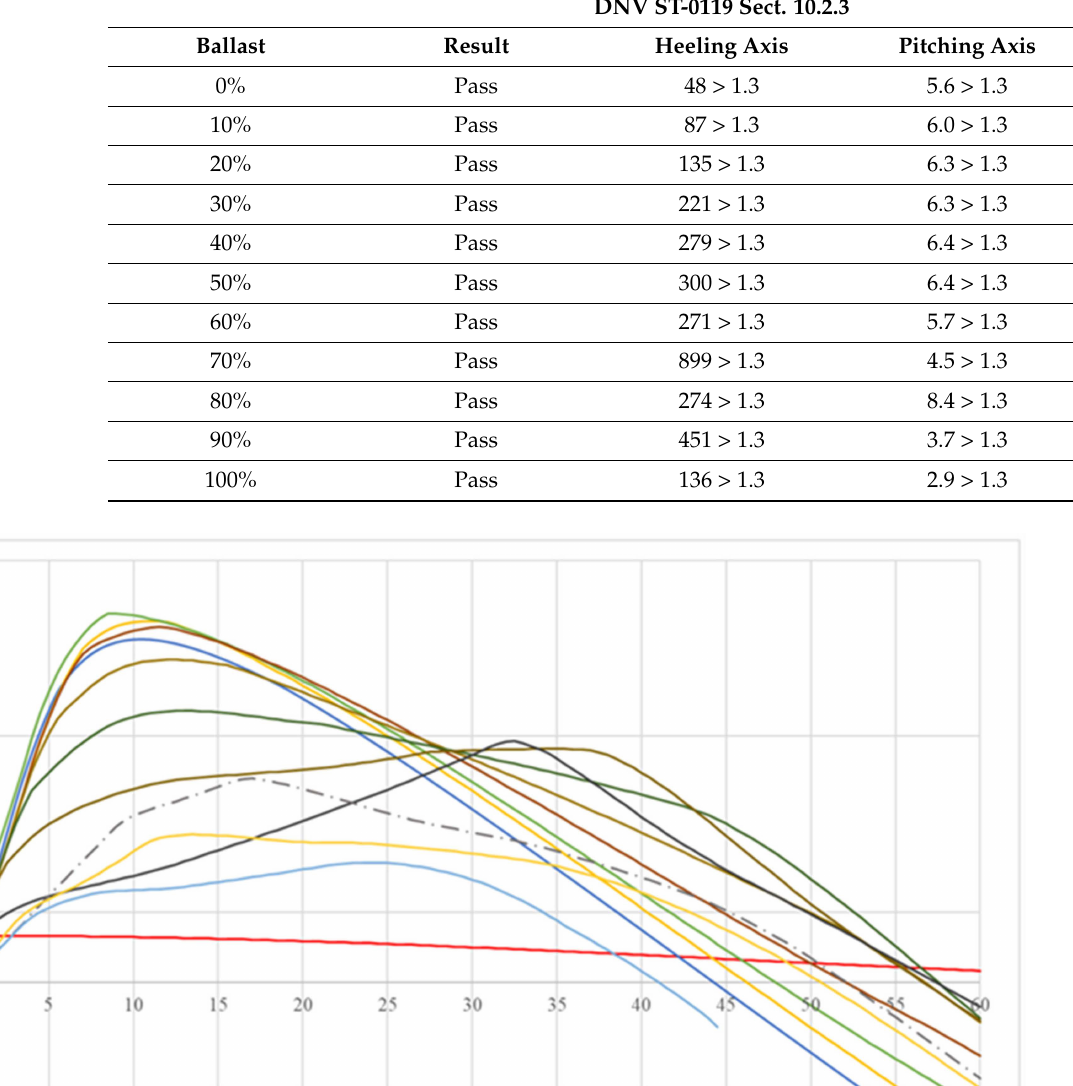
Table 9. Results of SA: RW.